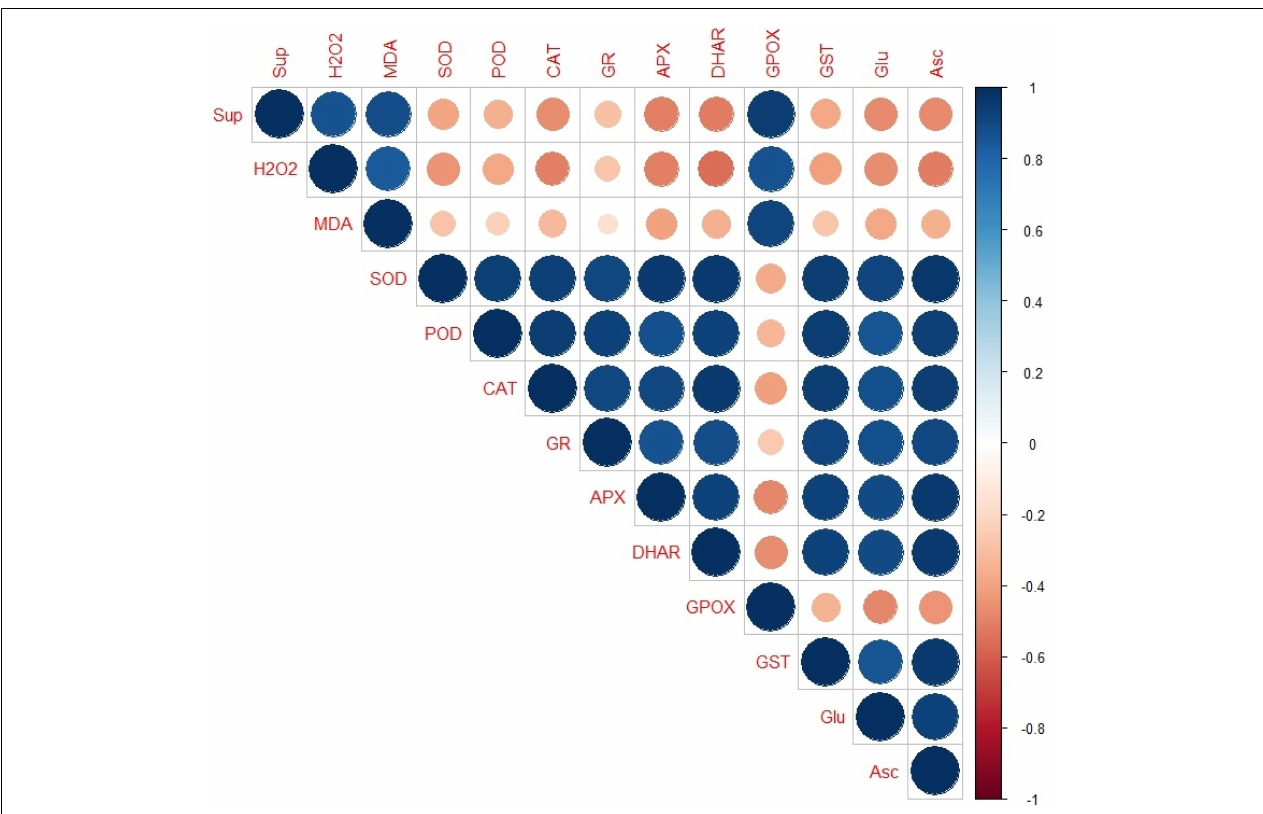
FIGURE 7 | Corr-plot representing the Pearson’s correlation analysis between the oxidative stress markers and oxidative defence molecules (enzymatic andnon-enzymatic). Here, the size of the circles is proportional to the absolute value of correlation coefficients, whereas their colour represents the value in positive or negative correlation region as represented in the right bar of varying colour intensities from intense blue to intense red, ranging from + 1 to − 1, respectively. Sup, superoxide anion; H 2 O 2 ,hydrogen peroxide; MDA, malondialdehyde; SOD, superoxide dismutase; POD, guaiacol peroxidase; CAT, catalase; GR, glutathione reductase; APX/APOX, ascorbate peroxidase; DHAR, dehydroascorbate reductase; GPOX, glutathione peroxidase; GST, glutathione-S-transferase; Glu, glutathione; and Asc, ascorbic